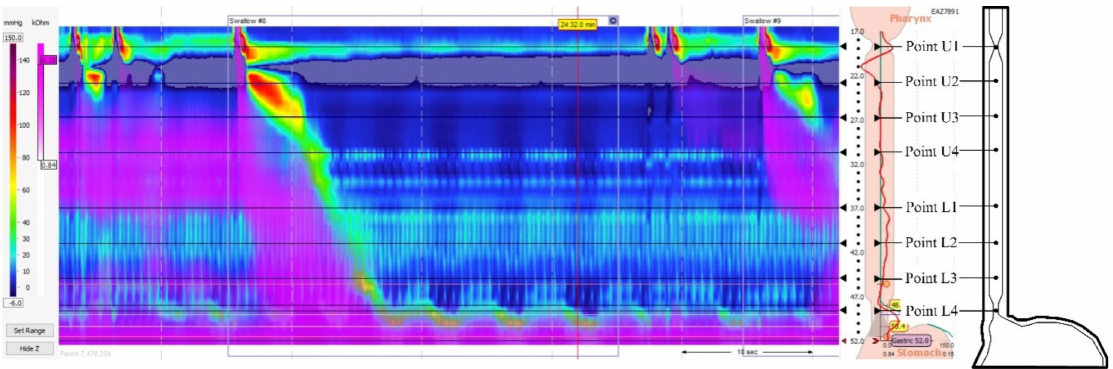
Figure 1. Illustration of esophageal pressure assessment points and normal pressure pattern finding in high-resolution esophageal